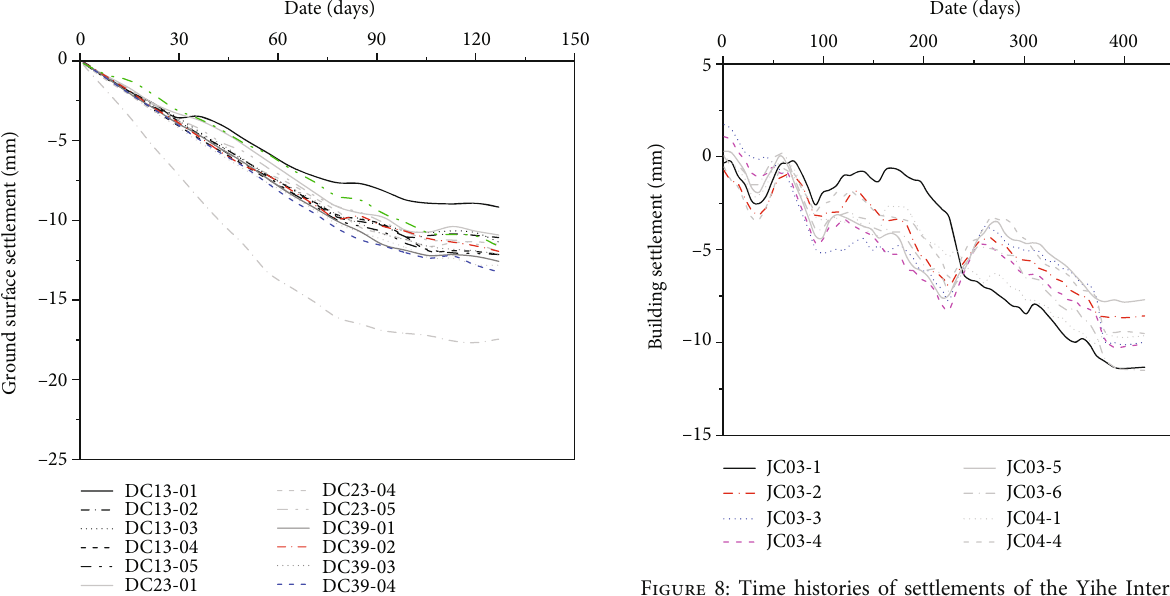
Figure 8: Time histories of settlements of the Yihe International Building.